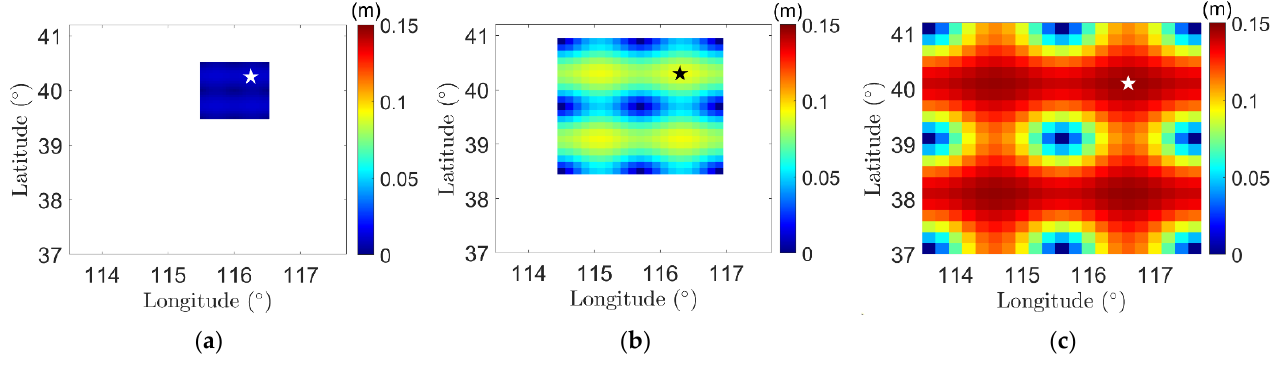
Figure 5. Formal precision of the between-satellite network corrections of C26 and C29 using: ( a ) Network 1; ( b ) Network 2; ( c ) Network 3 on L1 phase. σ ι